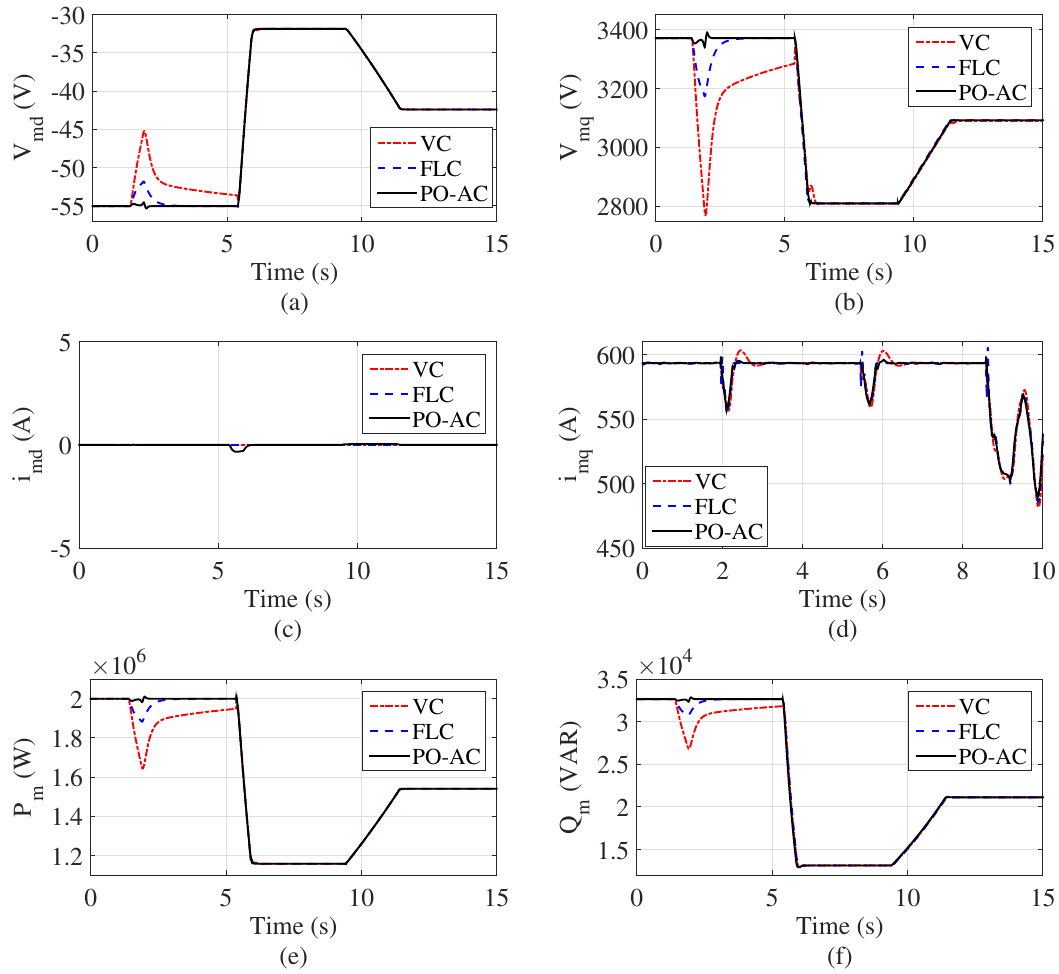
Figure 5. Responses of the PMSG to ramp wind speed. ( a ) d-axis voltage V md . ( b ) q-axis voltage V mq . ( c ) d-axis current i md . ( d ) q-axis current i mq . ( e ) Active generating power P m . ( f ) Reactive generating power Q m